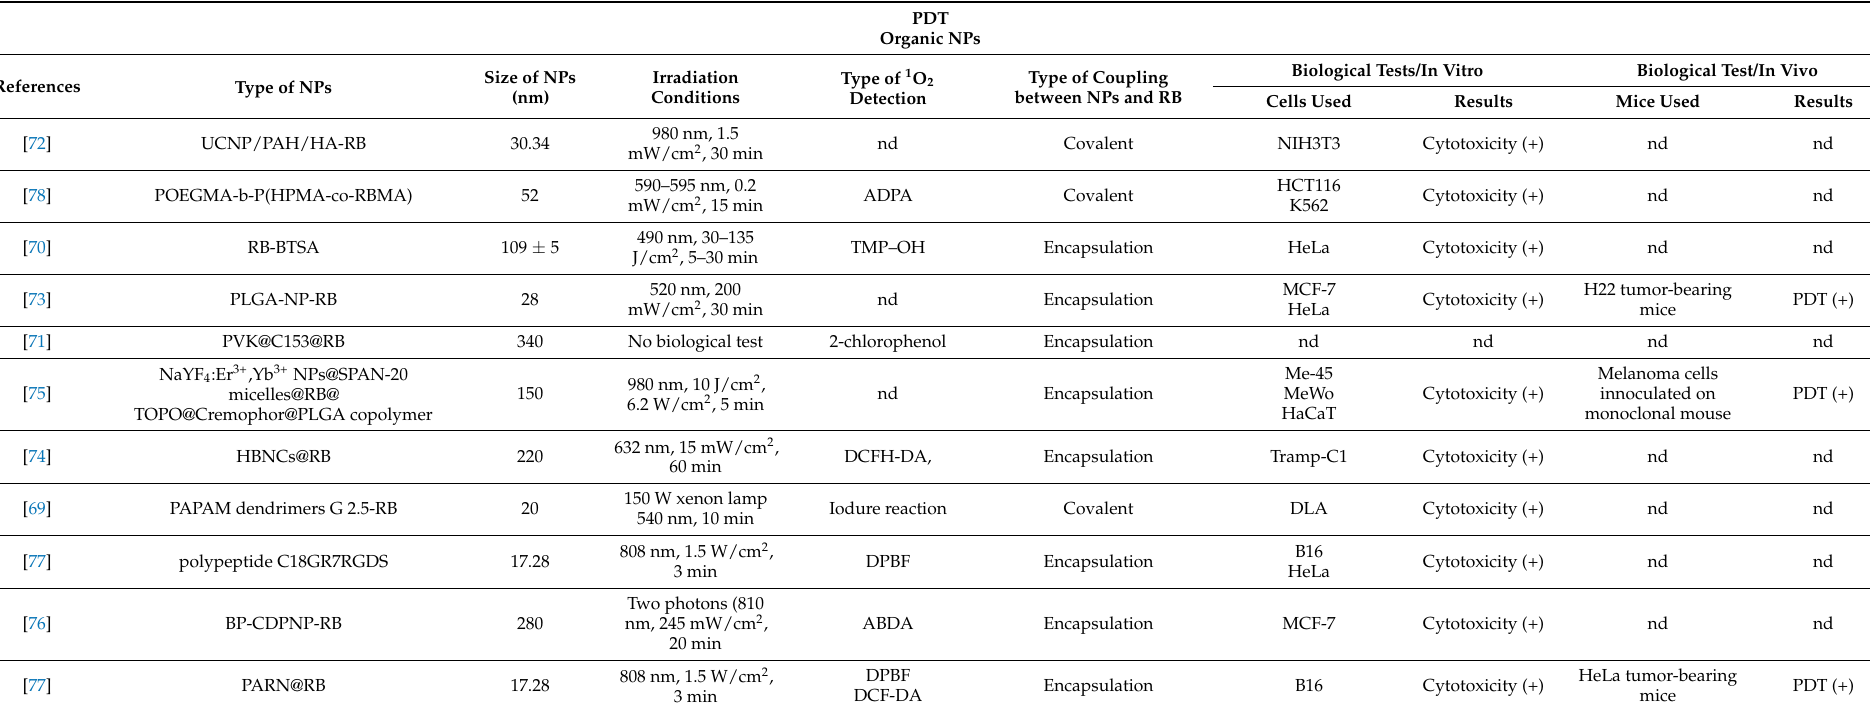
Table 3. References dealing with organic NPs@RB, including the type of NPs, as well as their size, excitation wavelength, type of detection of 1 O 2 , the type of coupling between the NPs and the RB, and the type of biological experiments